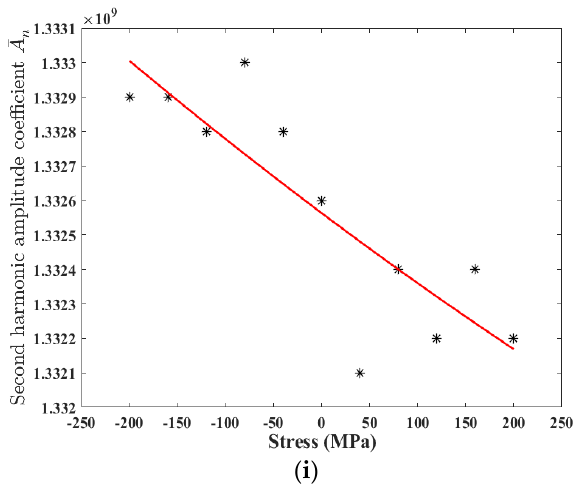
Figure 7. Amplitudes of the second harmonic mode generated by mode combinations vary with the stress: ( a ) mode pair 7; ( b ) mode pair 8; ( c ) mode pair 9; ( d ) mode pair 10; ( e ) mode pair 11; ( f ) mode pair 12; ( g ) mode pair 13; ( h ) mode pair 14; and ( i ) mode pair 15.